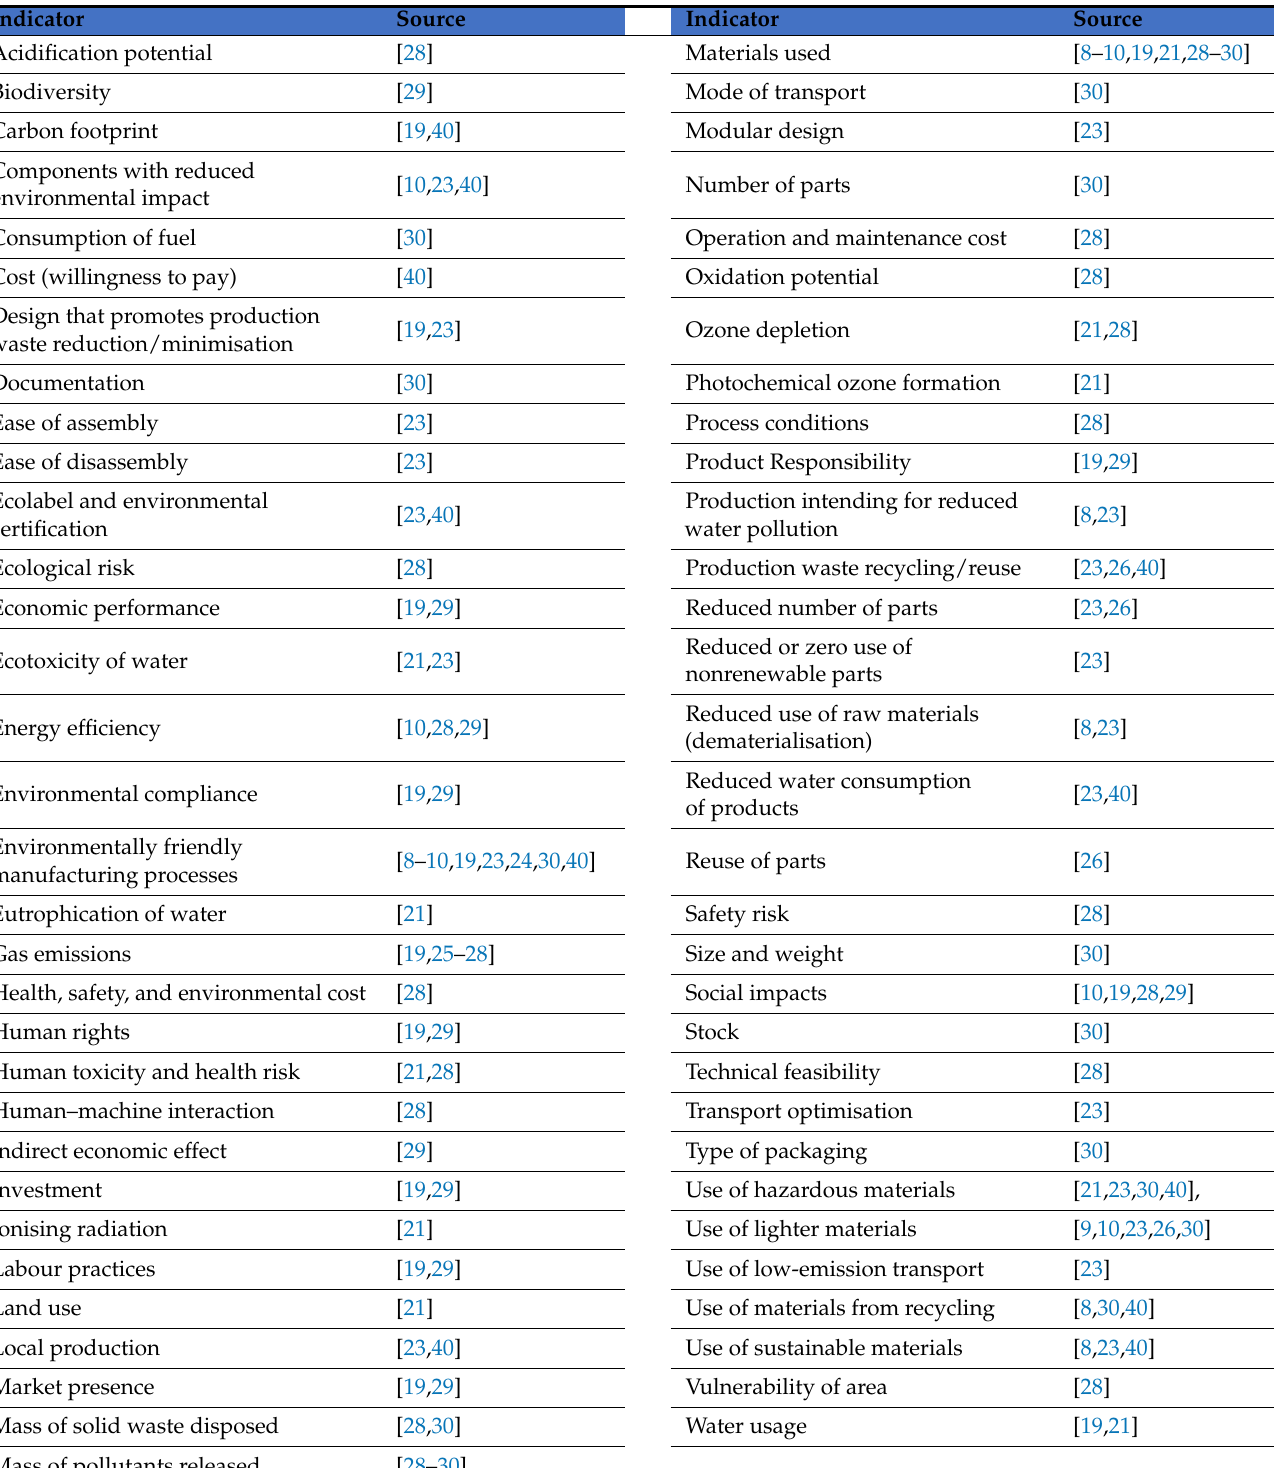
Table 4. A list of semantically integrated indicators (own